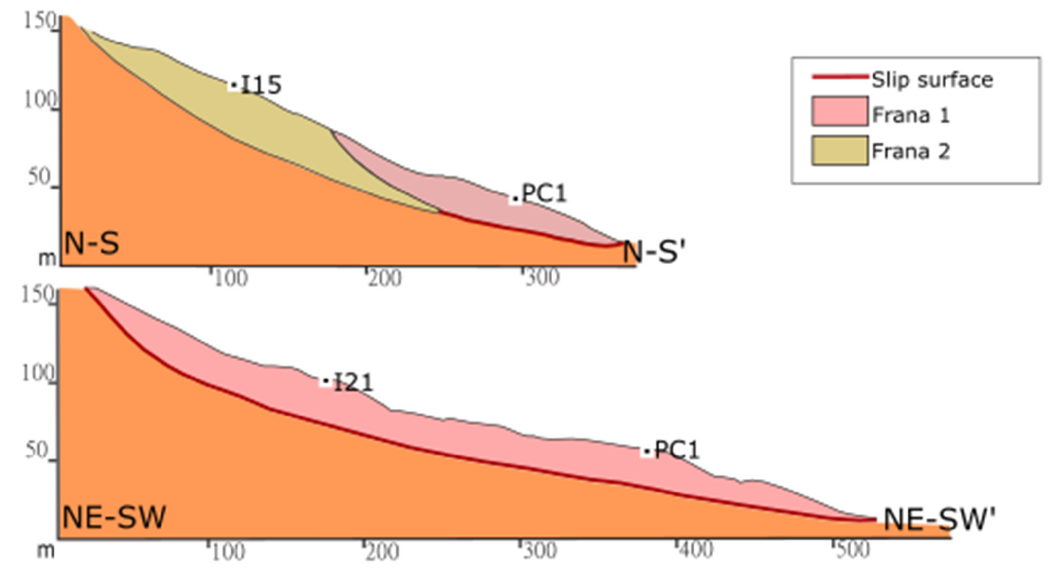
Figure 4. Cross sections of Frana 1-2 as seen in the map in Figure 3.